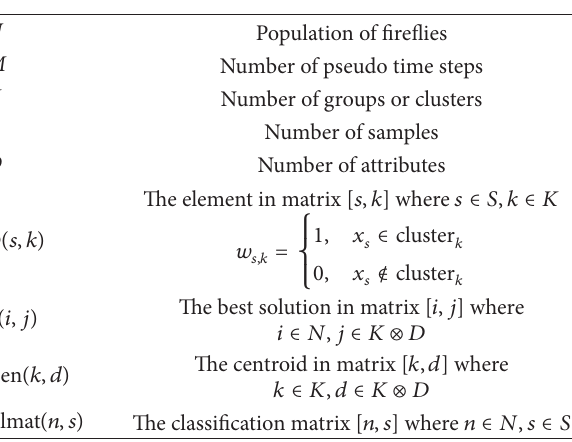
Table 1: Parameters used for C-Firefly. Table 2: Parameters used for C-Cuckoo.